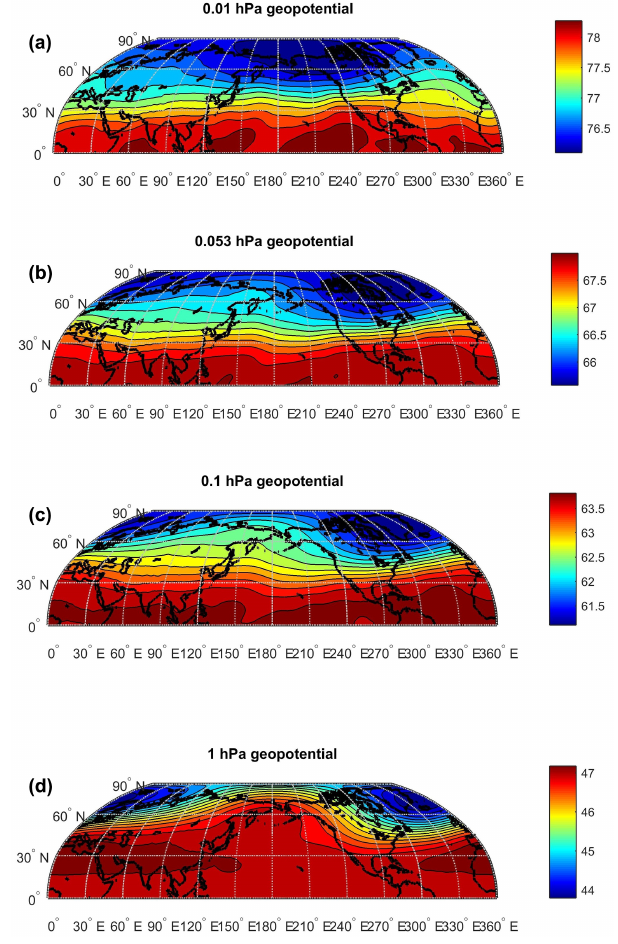
Figure 3. The climatology of geopotential heights (composite of 2006, 2008 and 2010) for January, four pressure levels of 1 (a) , 0.1 (b) 0.053 (c) and 0.01hPa (d) , NOGAPS-ALPHA data. Horizontal axis, longitude; vertical axis, latitude.